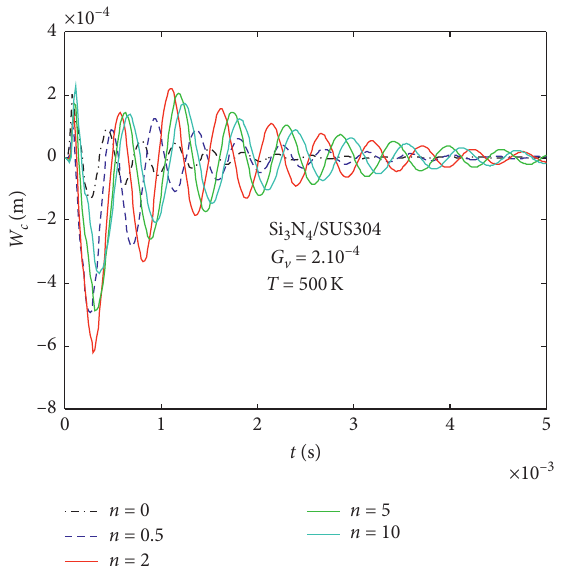
Figure 12: The dependence of w k ∗